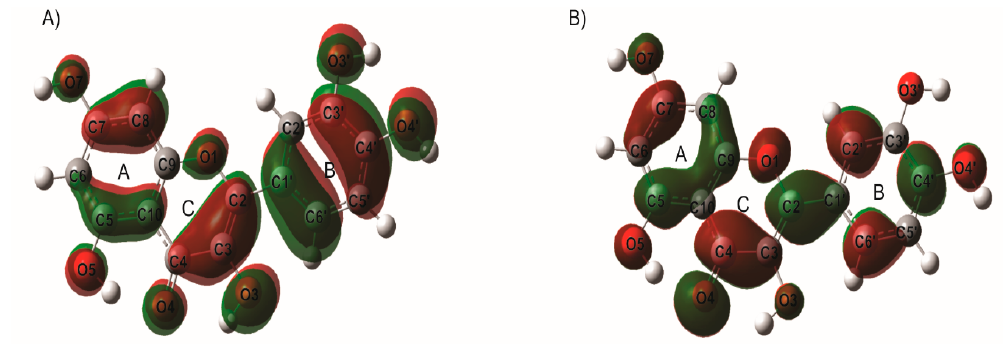
Figure 4. Localization of ( A ) HOMO and ( B ) LUMO molecular orbitals of quercetin (Q), calculated with B3LYP/6-31G (d,p) methodology. Processes 2020 , 8 , x FOR PEER REVIEW